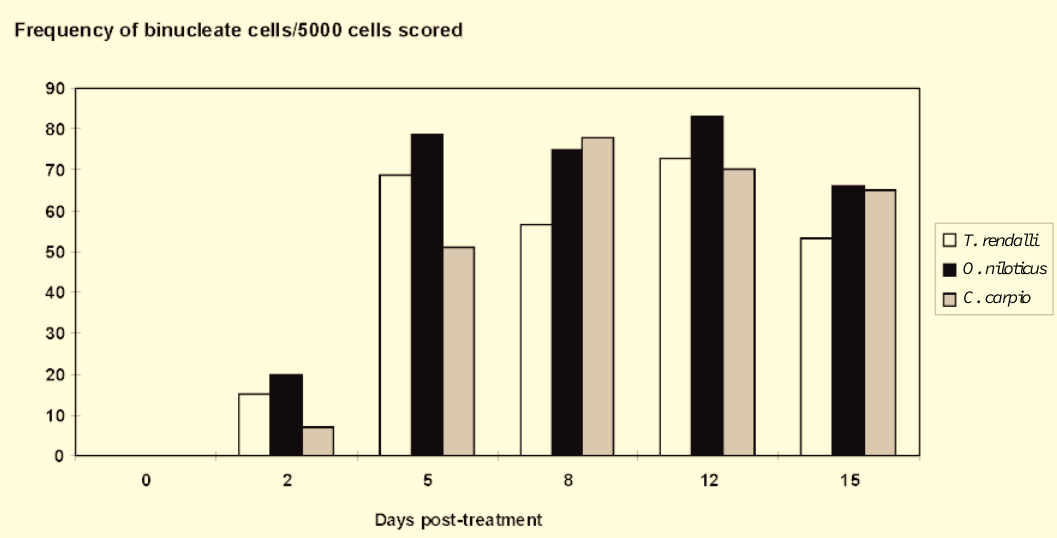
Figure 2 - Rate of binucleate to mononucleate erythrocytes 0-15 days after treatment with